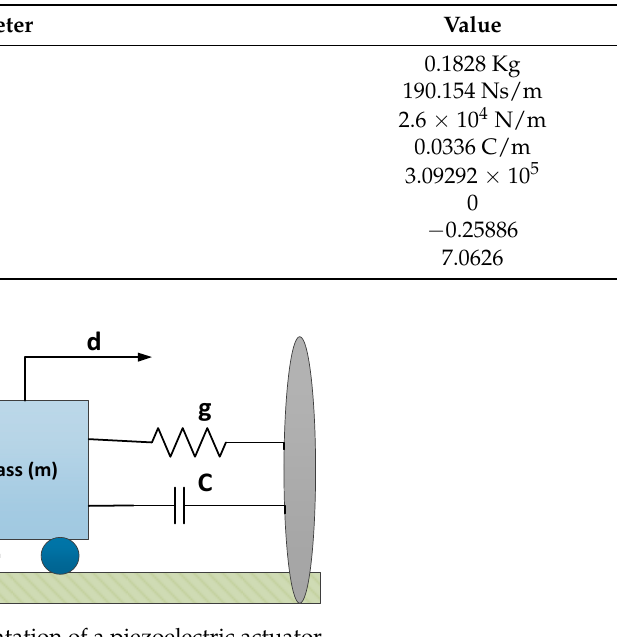
Figure 1. Pictorial representation of a piezoelectric